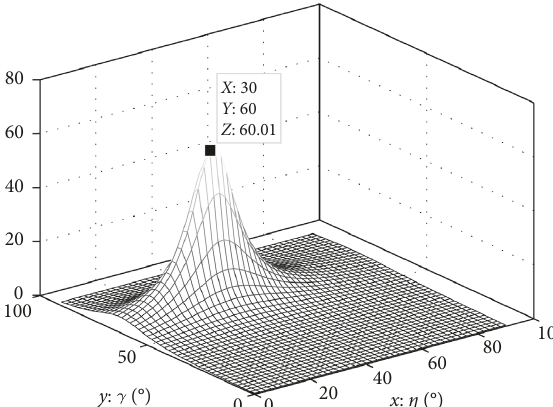
Figure 6: Polarization estimation result with ( θ , ϕ ) � ( 90 ° , 40 ° )